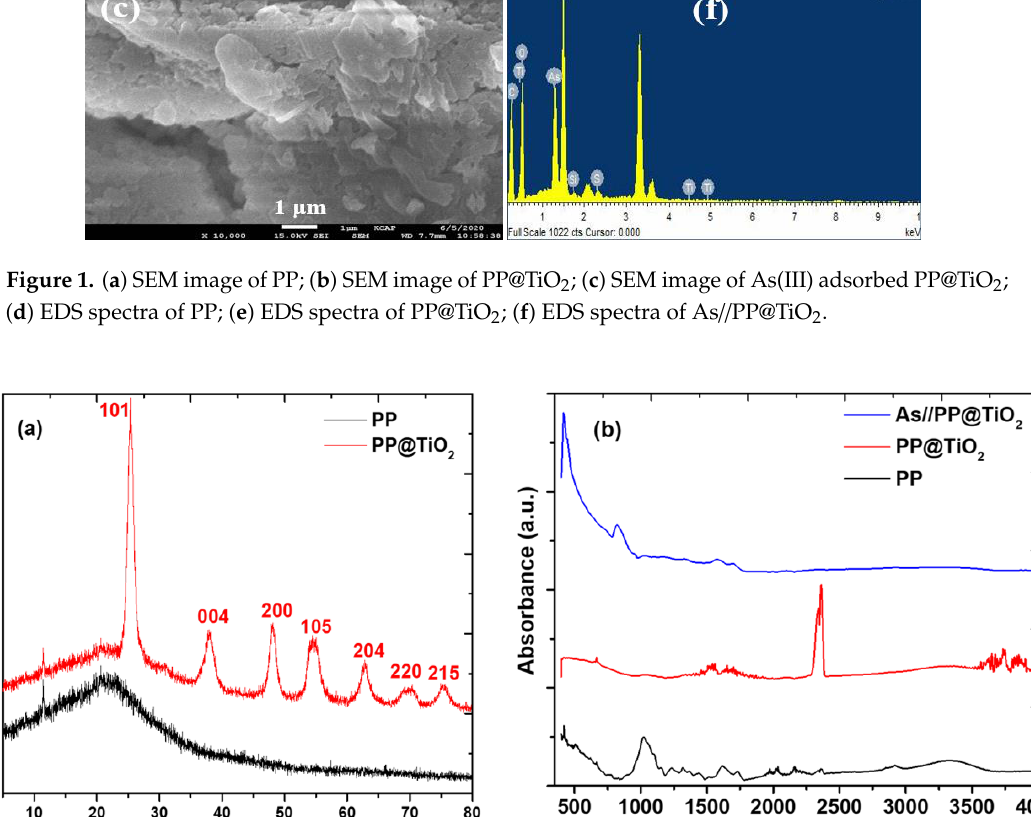
Figure 2. ( a ) XRD spectra of PP and PP@TiO 2 ; ( b ) FTIR spectra of PP, PP@TiO2, and As// PP@TiO 2 .